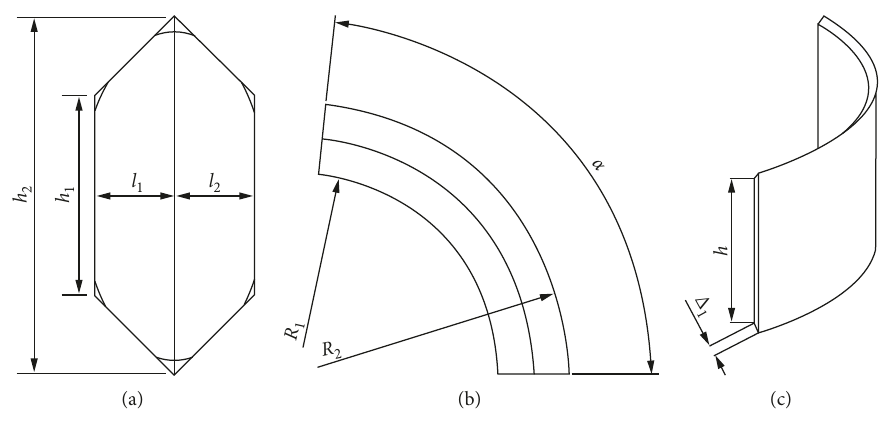
Figure 8: Calculation model. (a) Section. (b) Top view. (c)